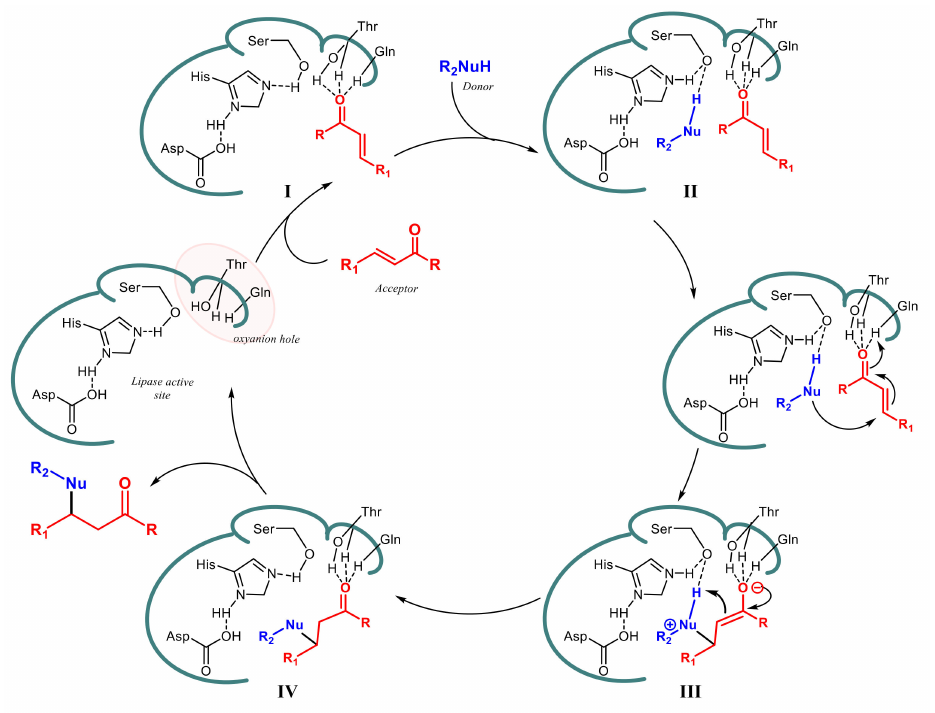
Scheme 15. Proposed mechanism for lipase-catalyzed Michael